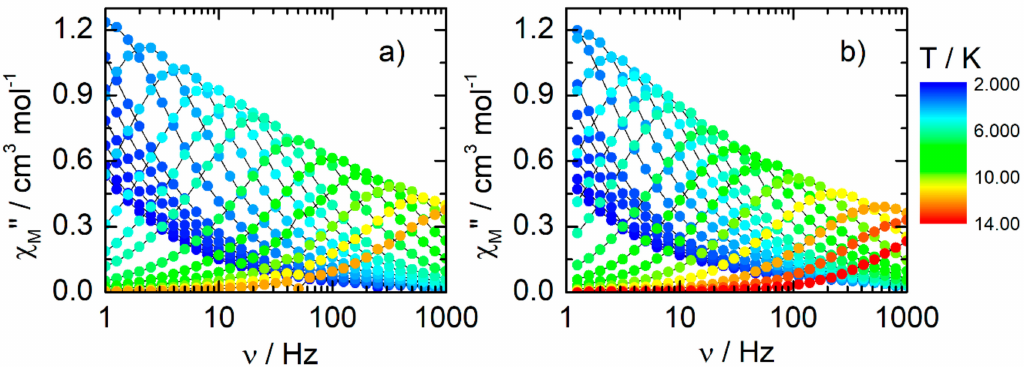
Figure 8. Frequency dependence of χ M ” ( a ) between 2 and 12 K for 1 and ( b ) between 2 and 14 K for 2 in 1200 and 1000 Oe applied magnetic fields,